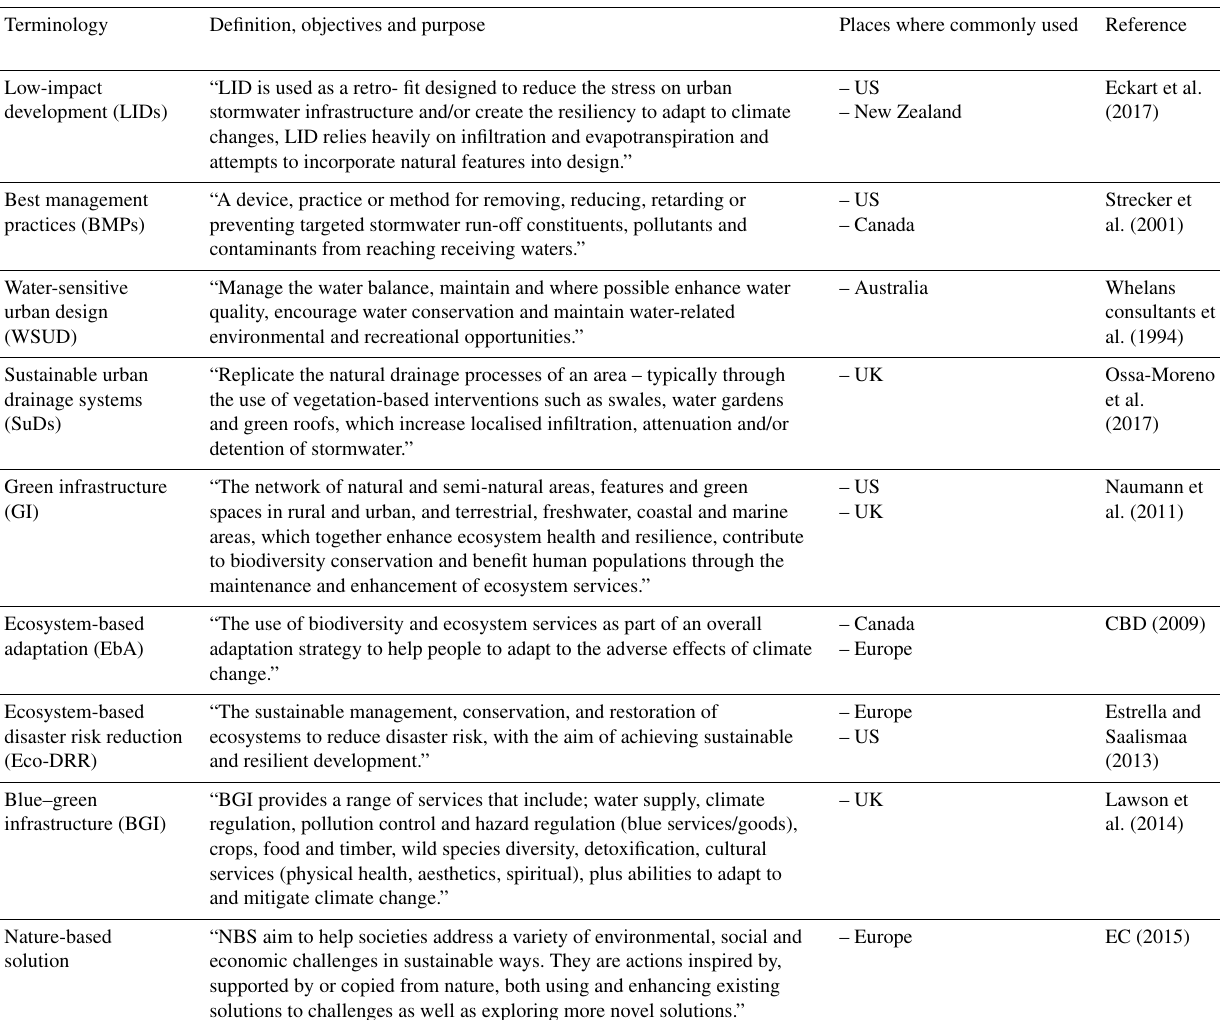
Figure 1. Timeline and year of origin of each term (low-impact developments – LIDs, best management practices – BMPs, water-sensitive ur- ban design – WSUD, green infrastructure – GI, sustainable urban drainage systems – SuDs, nature-based solutions – NBSs, ecosystem-based adaptation – EbA, ecosystem-based disaster risk reduction – Eco-DRR – and blue–green infrastructure – BGI) based on their appearance in publications. Table 1. Glossary of terms and their geographical